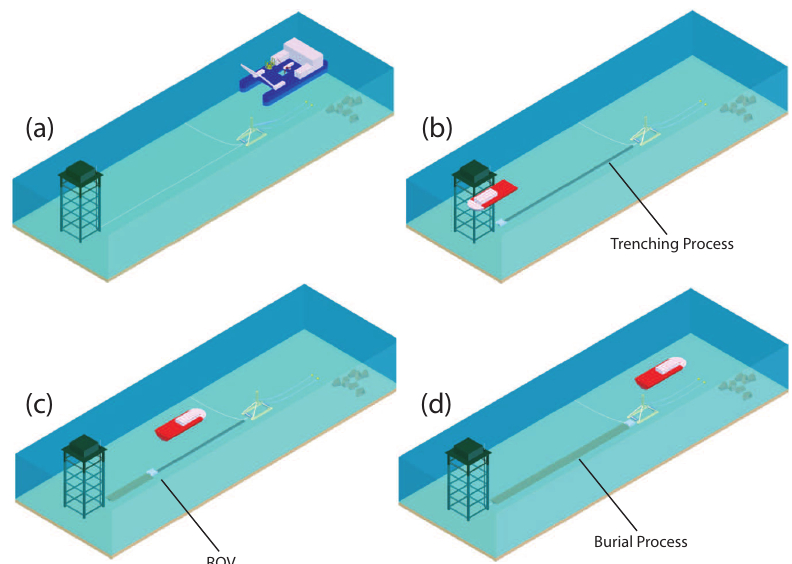
Figure 2. Installation of the submarine cables: ( a ) installation of the base; ( b ) ROV (Remotely Operated